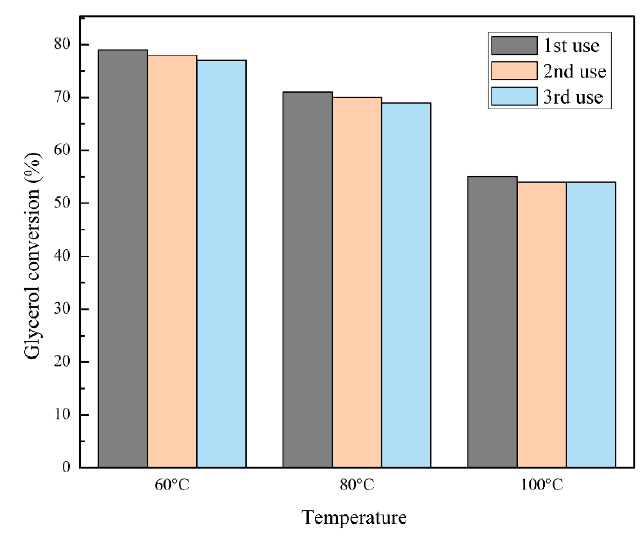
Figure 5. Catalyst reuse. Reaction conditions: Time = 240 min; A/G = 6; and mcat = 0.25% wt.